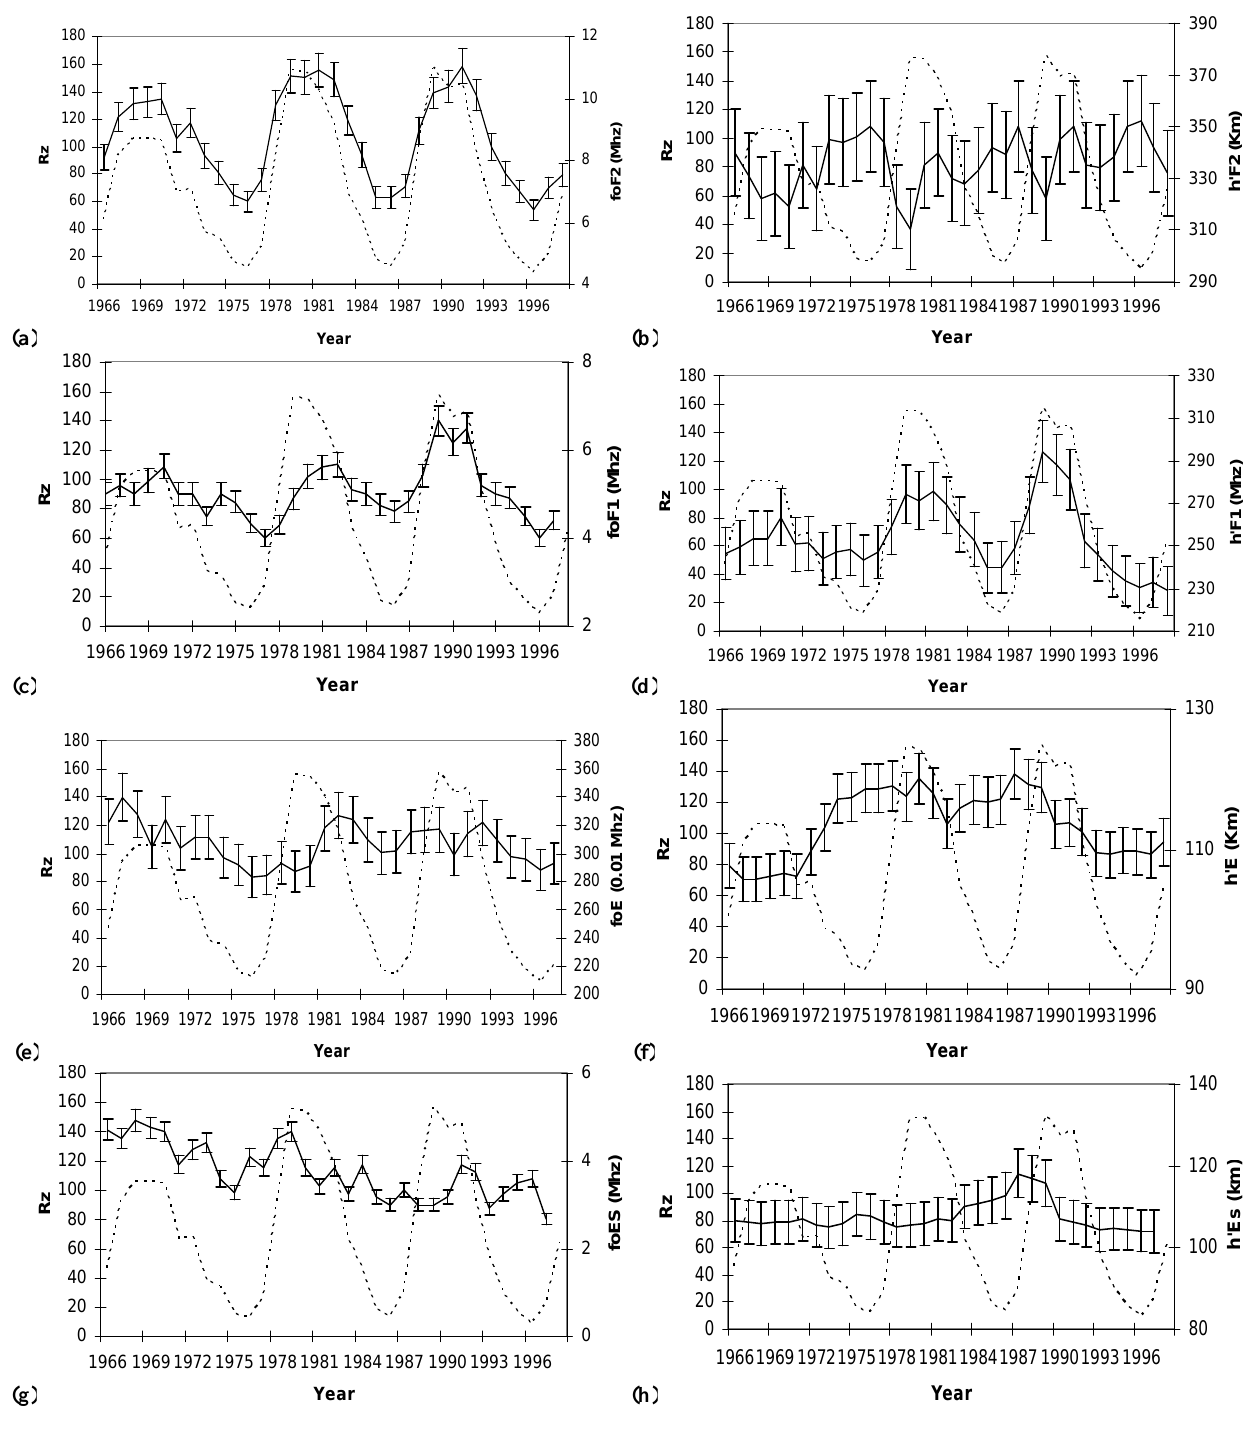
Fig. 1. Yearly variation of ionospheric parameters (solid line) such as critical frequencies (left row) and virtual heights (right row) with sunspot number (dotted line). The vertical bars indicate standards deviation. First line (panels a and b ): parameters of layer F2. Second line (panels c and d ) parameters of layer F1. Third line (panels e and f): parameters of layer E. Fourth line (panels g and h ) parameters of layer